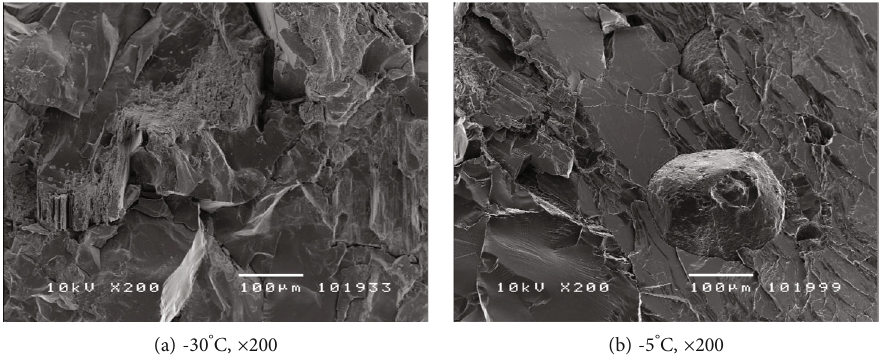
Figure 20: Quasicleavage fracture.